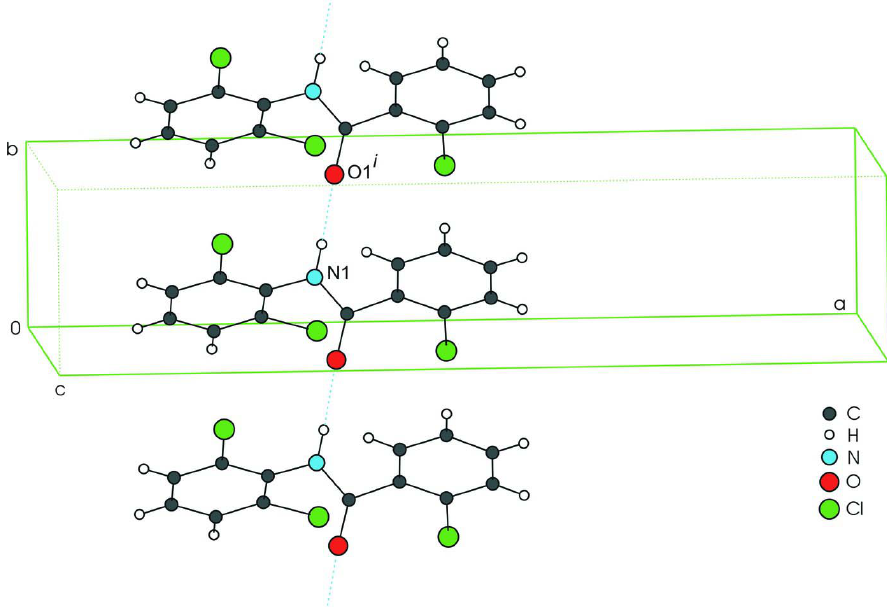
Figure 2 Part of the crystal structure of the title compound with infinite molecular chains running along the b axis of the crystal. The chains are generated by N—H···O (i) hydrogen bonds. Symmetry operation (i): x , y + 1, z . 2-Chloro- N -(2,6-dichlorophenyl)benzamide Crystal data H Cl NO C 13 8 3 = M r